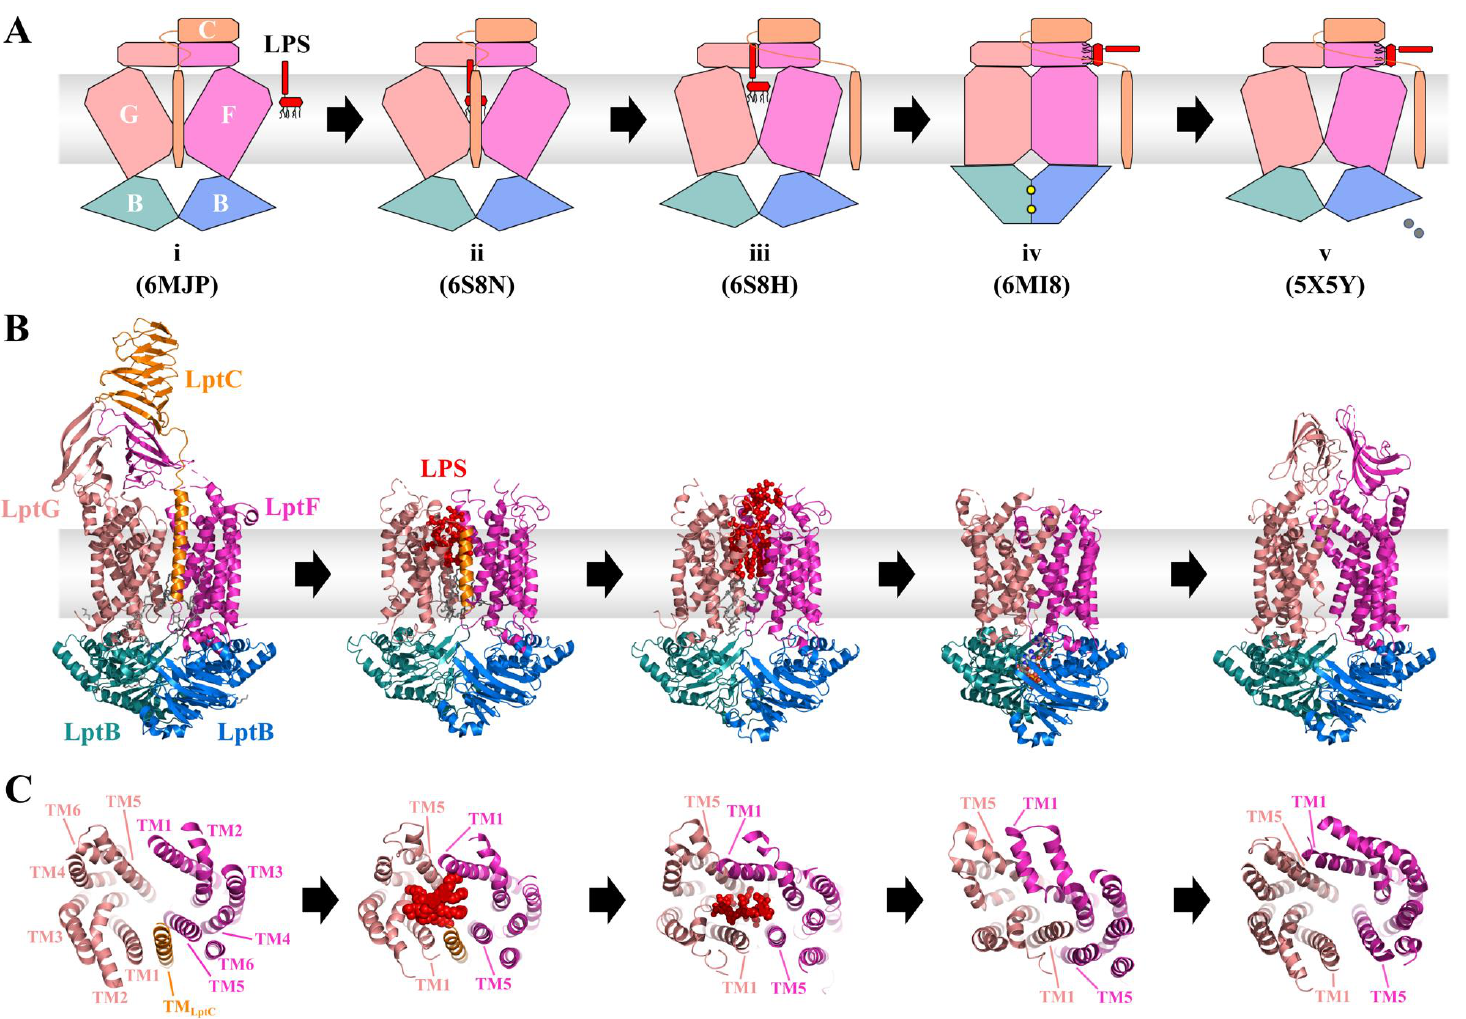
Figure 7. Model and structures of the Lpt systems transport cycle. LptC is shown in orange, while LptF and LptG are shown in light magenta and salmon, respectively. Both LptB protomers are shown in marine and deep teal. LPS is shown in red. Lipids and detergent molecules in the structure are shown as grey